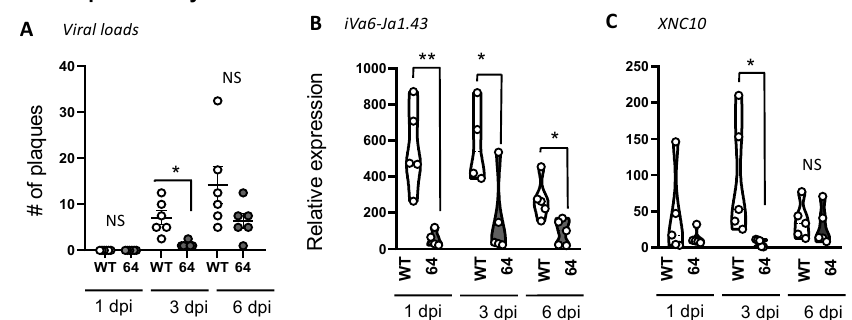
Figure 3. The iV α 6 T cell response in tadpoles depends on active viral replication and productive FV3 infection. Three week-old (stage 55) tadpoles were infected with 10,000 PFUs of WT-or ∆ 64-FV3. At 1, 3, and 6 dpi, kidneys were collected and the total number of infectious particles was determined by plaque assay, respectively ( A ). Gene expression of iV α 6-J α 1.43 ( B ) and XNC10 ( C ) was determined relative to an endogenous control (GAPDH) and relative expression was calculated against the lowest observed expression according to the ∆∆ Ct method ( n = 5). No iV α 6-J α 1.43 transcripts were detected in the kidney uninfected tadpoles. * p < 0.05 and ** p < 0.01 above the line denotes statistically significant di ff erences between treatment groups; NS indicates no significant di ff erences (one way ANOVA and Dunn’s multiple comparison